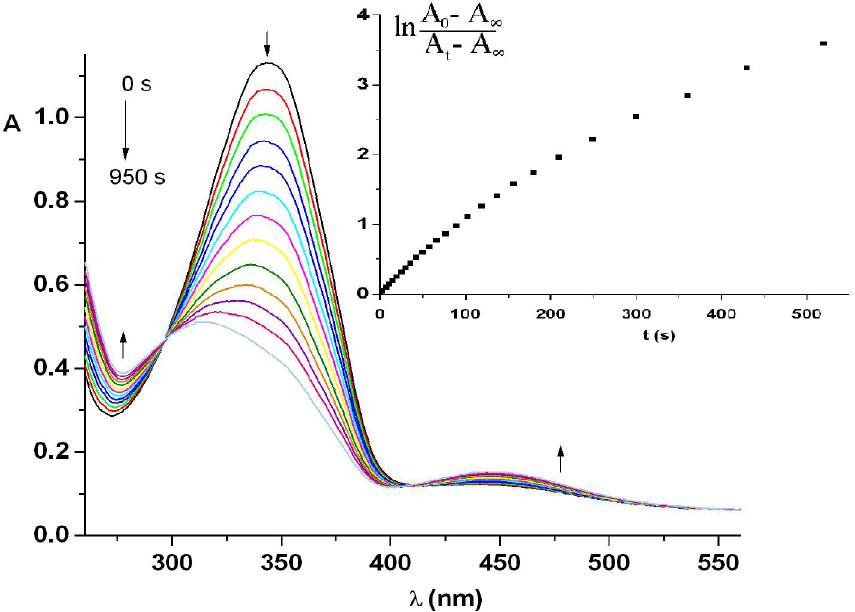
Figure 11. Spectral changes of poly(methyl methacrylate) (PMMA) film containing azochromophore under UV irradiation (365 nm). Inset shows the trans-cis photoisomerization